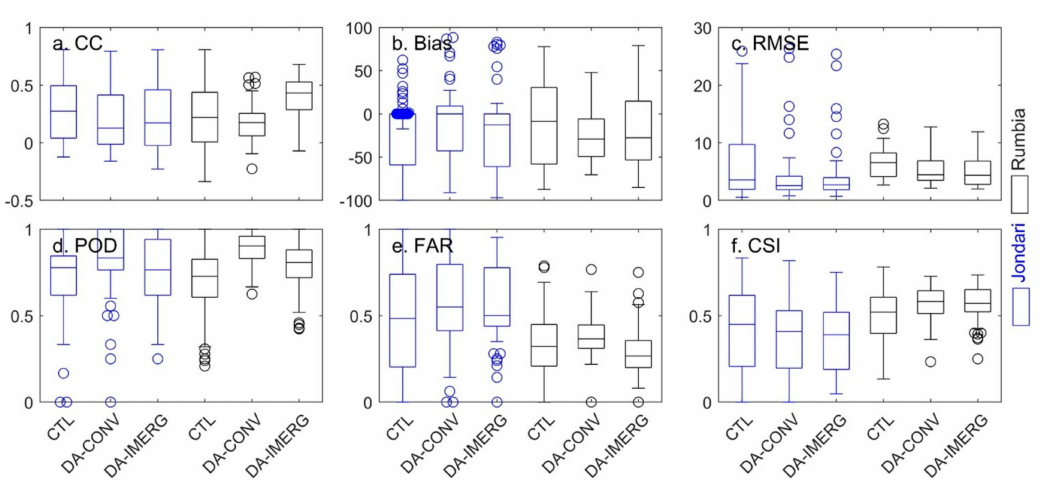
Figure 10. Boxplots of statistical indices of CC ( a ), Bias ( b ), RMSE ( c ), POD ( d ), FAR ( e ), and CSI ( f ) for the CTL, DA-CONV, and DA-IMERG. Table 6. Statistical indices of mean hourly precipitation for the CTL, DA-CONV, and DA-IMERG. CC Bias (%) RMSE (mm) POD FAR CSI CTL 0.28 3.73 5.92 0.71 0.47 0.42 Jondari DA-CONV 0.21 15.88 4.41 0.81 0.57 0.39 DA-IMERG 0.20 − 4.81 4.32 0.73 0.58 0.36 CTL 0.23 25.29 0.49 DA-CONV 0.18 − 19.25 5.44 0.89 0.39 0.56 Rumbia DA-IMERG 0.41 − 13.84 5.09 0.78 0.30